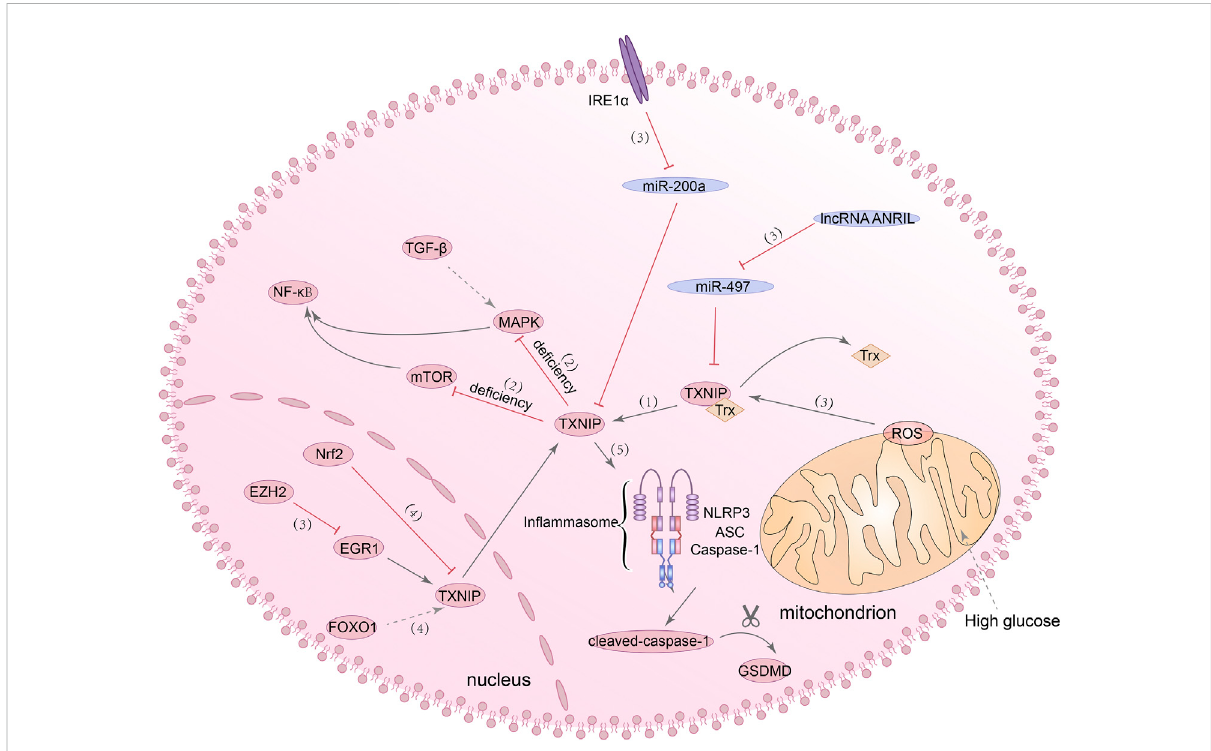
FIGURE 3 TXNIP/NLRP3 signaling pathway isinvolvedintheregulation ofpyroptosis.(1)TXNIPcaninhibittheantioxidantactivityofTrx.(2)The de fi